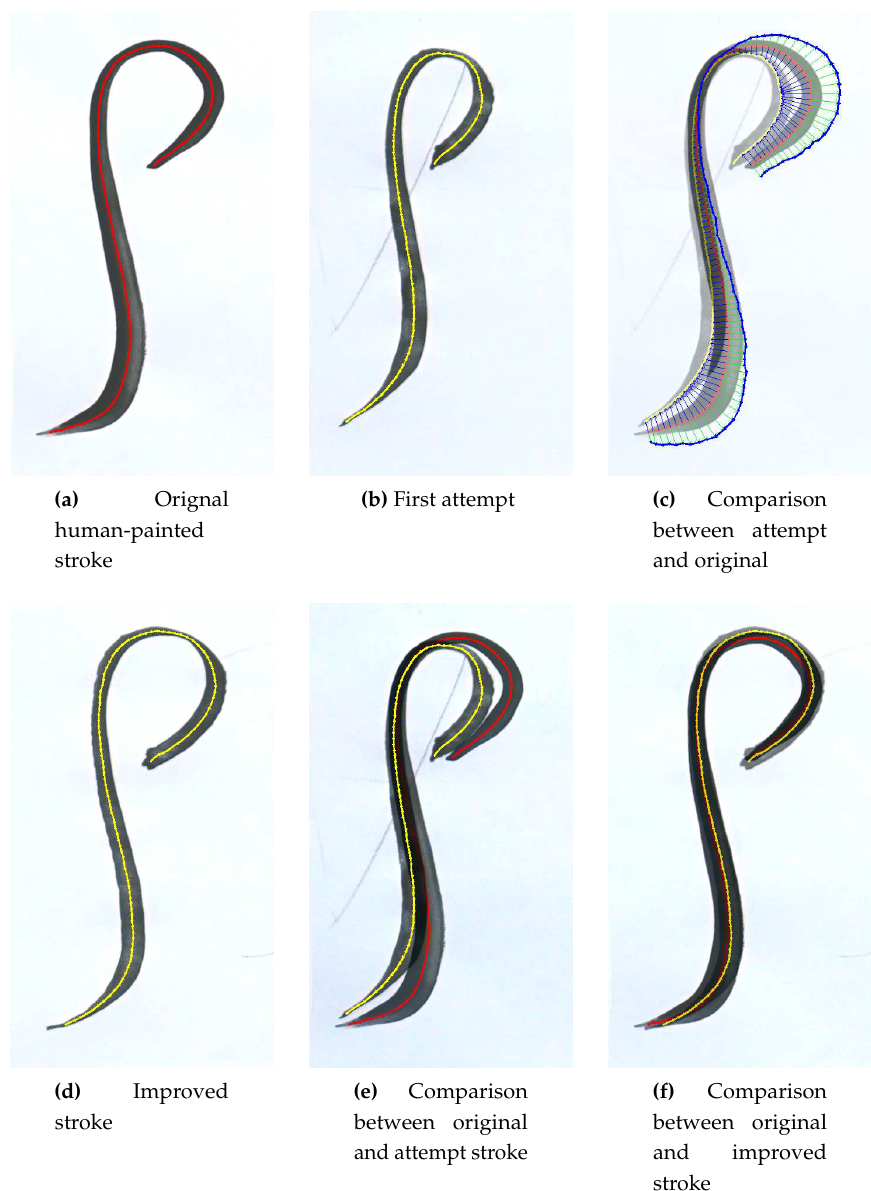
Figure 10. The steps performed for the stroke improvement method.